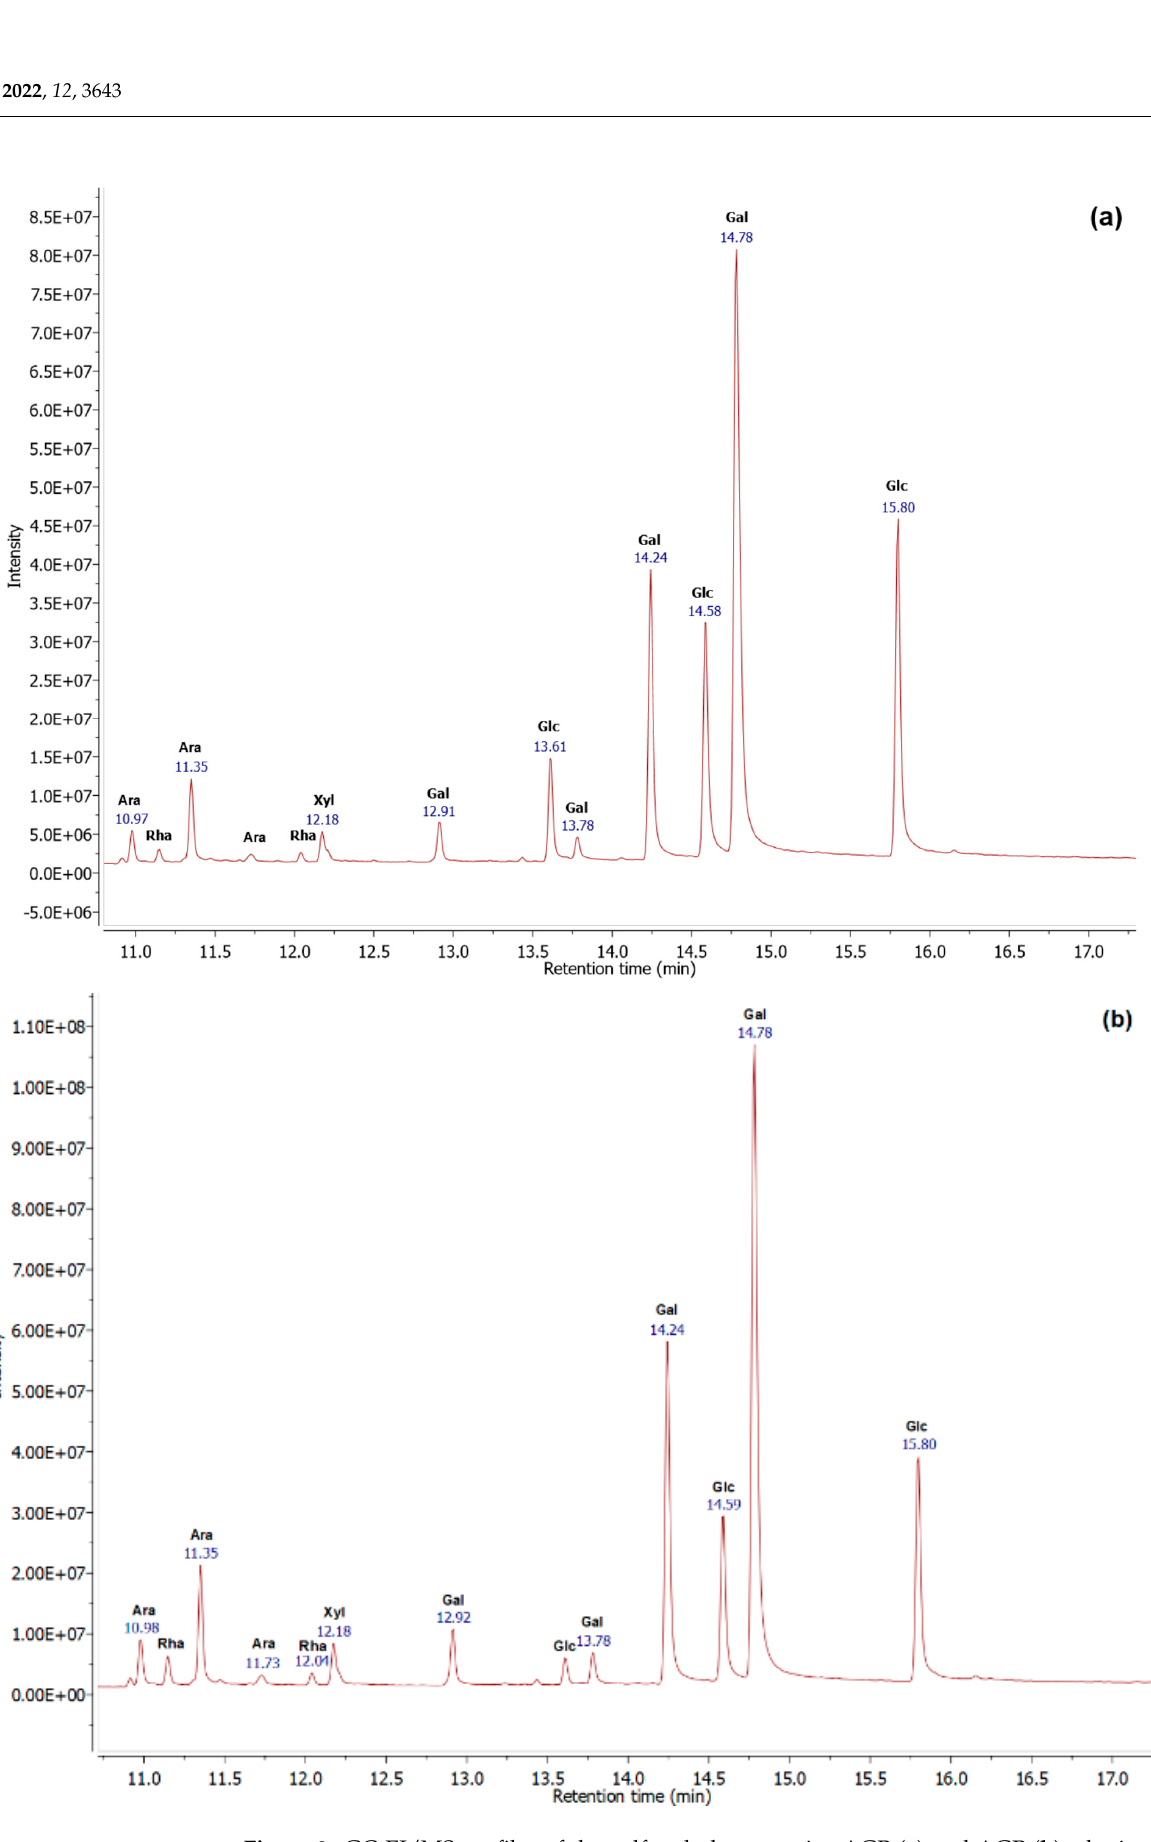
Figure 2 . GC–EI/MS profiles of the sulfated glycoproteins AGB ( a ) and AGP ( b ), obtained using OPTIMA–1MS (30 m, 0.25 mm, 0.25 µm) column at a flow rate of 1.75 mL/min. OPTIMA-1MS (30 m, 0.25 mm, 0.25 µ m) column at a flow rate of 1.75